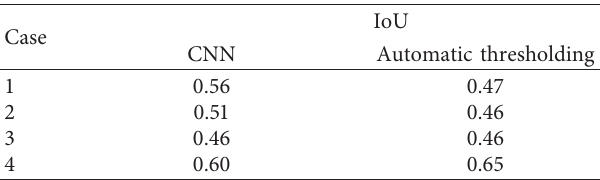
Figure 13: Experimental damage identified with an automatic thresholding method. Normalized damage sizes: (a) 0.09 (Case 1), (b) 0.12 (Case 2), (c) 0.14 and 0.07 (Case 3), and (d) 0.11 and 0.17 (Case 4). The red circles/squares denote the true damage region. Table 5: Performance of the damage detected using CNN and automatic thresholding